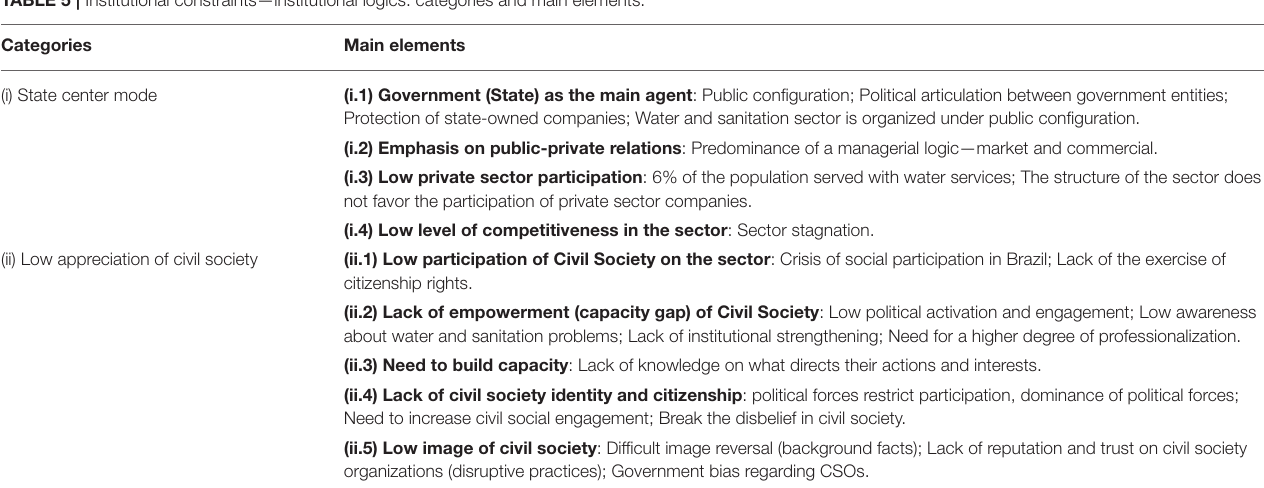
TABLE 5 | Institutional constraints—institutional logics: categories and main